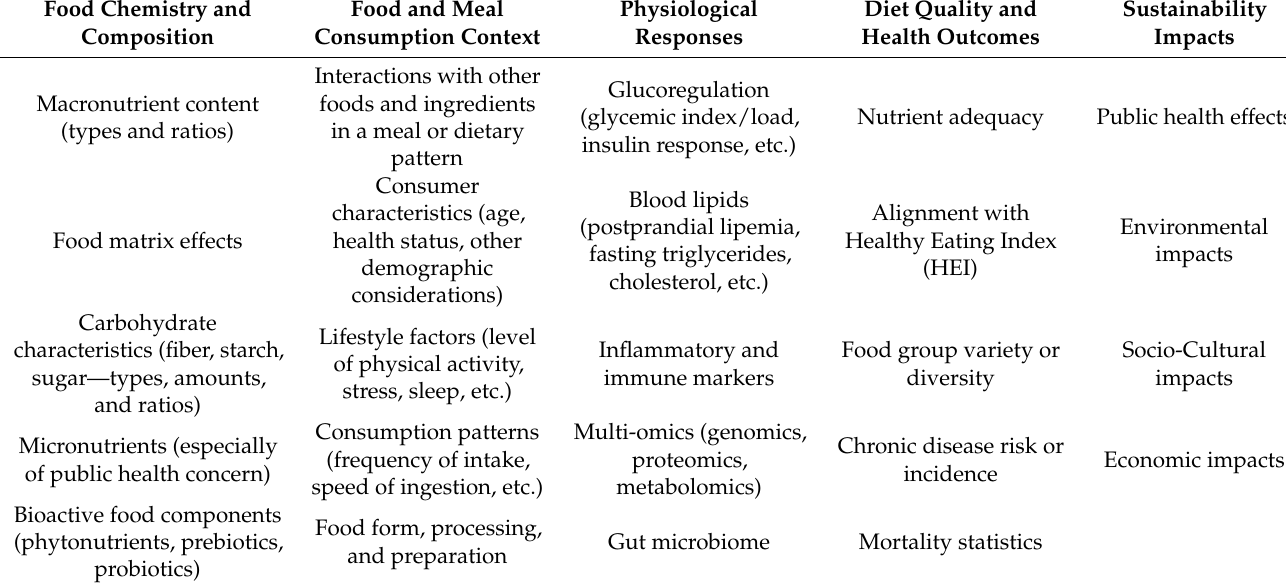
Table 2. Potential Indicators for Assessing the Carbohydrate Food